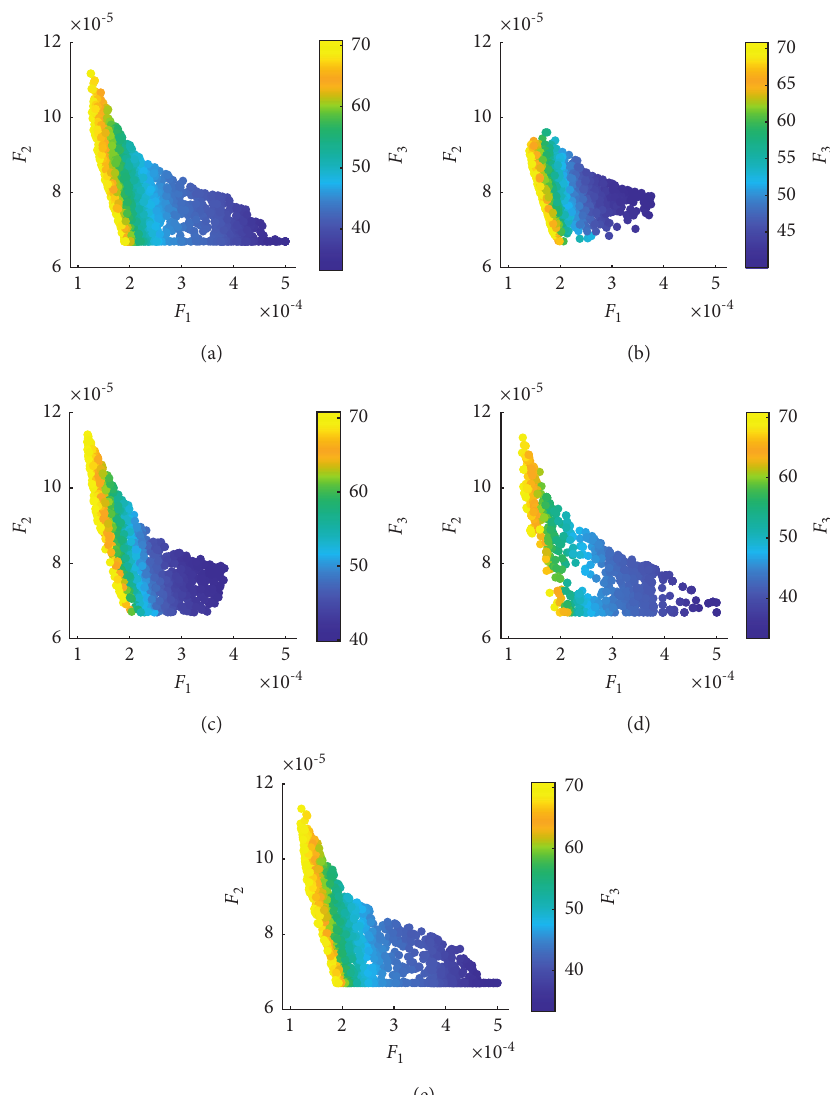
Figure 6: Final non-dominated solutions of series cushioning system. (a) PESA2. (b) SPEA2. (c) MOPSO. (d) MOEA/D. (e)